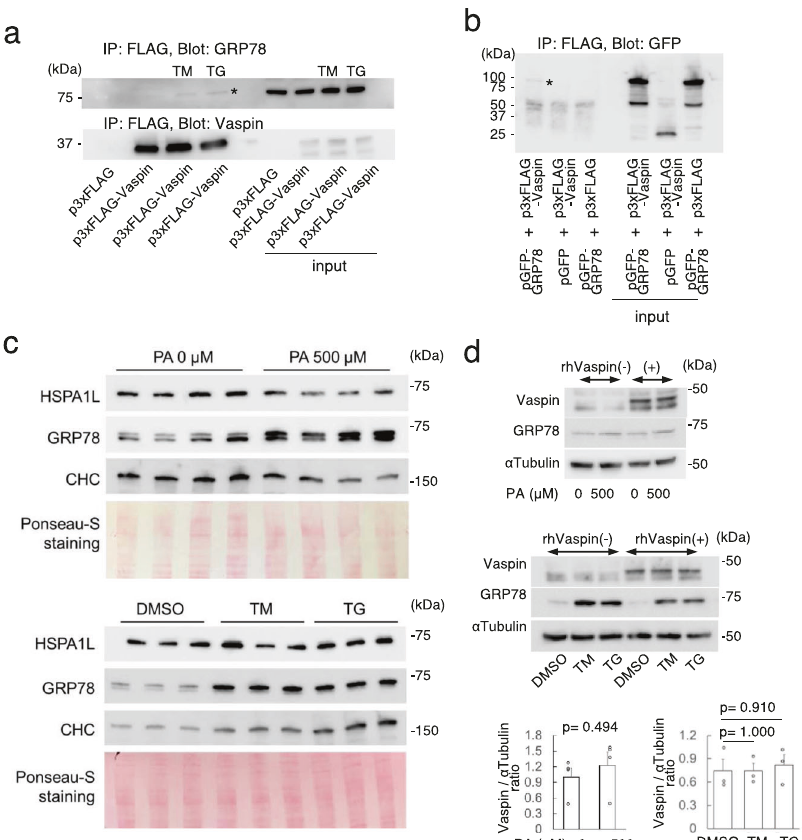
Fig. 5 Localization of GRP78 on cell surface and formation of a complex with Vaspin. a Immunoprecipitation using HK2 cell expressing p3xFLAG-Vaspin, with ANTI-FLAG M2 af fi nity agarose gel. Under 1 μ g/ml tunicamycin (TM) or 1 μ M thapsigargin (TG) induced ER stress enhanced condition, a binding of vaspin and GRP78 was visualized (asterisk). b Immunoprecipitation using HEK293T cells expressed p3xFLAG-Vaspin and pGFP-GRP78 with ANTI-FLAG M2 af fi nity agarose gel. GFP-GRP78 interacts with 3xFLAG-Vaspin (asterisk). c Western blot analyses of GRP78, HSPA1L and clathrin heavy chain (CHC) using cell surface protein of HK2 cells cultured with 500 μ M palmitate (PA), 1 μ g/ml TM and 1 μ M TG. Ponceau-S staining shows equal amount of protein loading. Cell surface GRP78 is prominently increased by PA, TM and TG. In contrast, HSPA1L is mildly increased by TM and TG, but rather decreased by PA. d Western blot analyses of HK2 cells cultured with 500 μ M PA, 1 μ g/ml TM and 1 μ M TG with or without 100 ng/ml rhVaspin for 24 h. Lower panel shows statistical analysis of Vaspin protein levels of HK2 cells under PA or TM or TG, which are normalized by α Tubulin. N = 3 – 4 independent experiments. Unpaired 2-tailed by Student ’ s t for 2 groups comparison or one-way ANOVA with Tukey-Kramer method for multiple comparison are used. Western blots were repeated